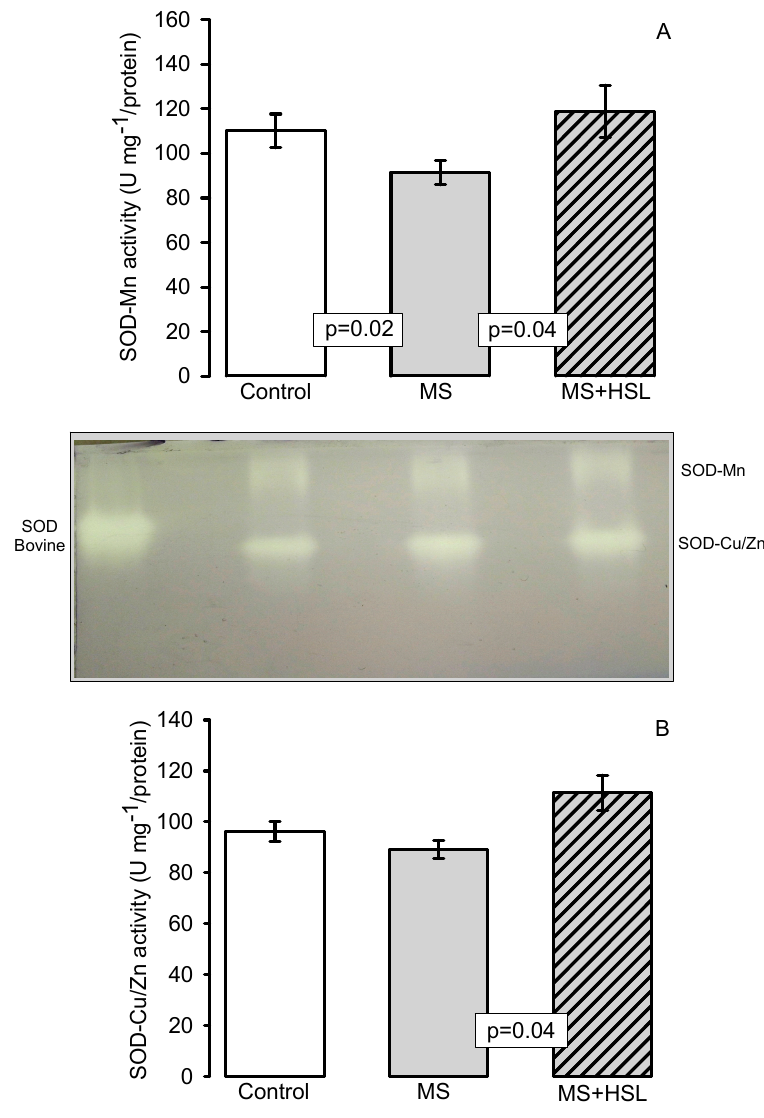
Figure 3. Histogram representing the densitophotometric analysis of the activity of the superoxide dismutase (SOD) isoforms in the kidney homogenates of the experimental rats. A representative native gel of the activities of the SOD-Mn, and SOD-Cu/Zn electrophoresis is shown between the graphs A and B is shown. ( A ) Mn isoform, and ( B ) Cu/Zn isoform. Abbreviations: MS = metabolic syndrome, MS+HSL = metabolic syndrome plus Hibiscus sabdariffa L . Mn = Manganese, Cu/Zn = Copper/Zinc Data are expressed in means ± SE, ( n = 8, rats in each group). Statistical significance was